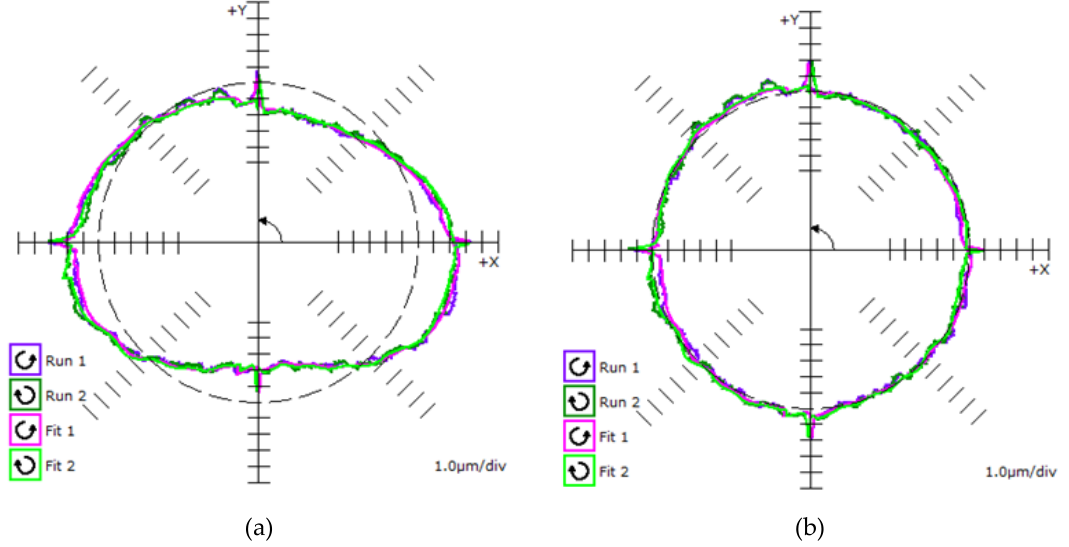
Figure 10. Circularity test—100 mm diameter: ( a ) without volumetric compensation; ( b ) with volumetric compensation. Table 10. Results of the circularity test—100 mm diameter.